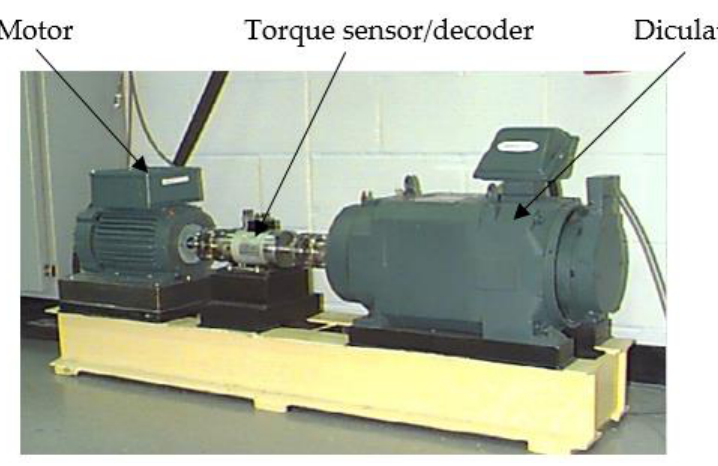
Figure 4. The experimental platform. Table 1. Fault feature frequencies.